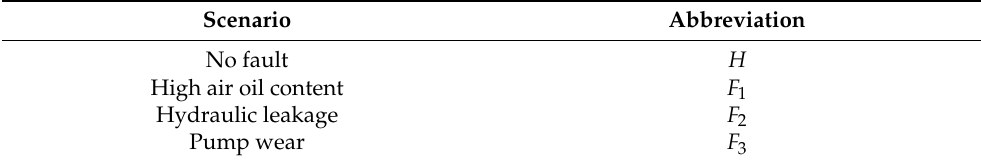
Table 1. Common faulty scenarios